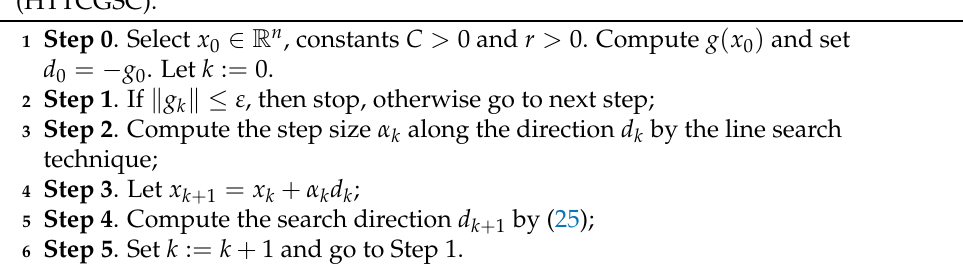
Algorithm 2: Hybrid three-term CG method using modified secant condition